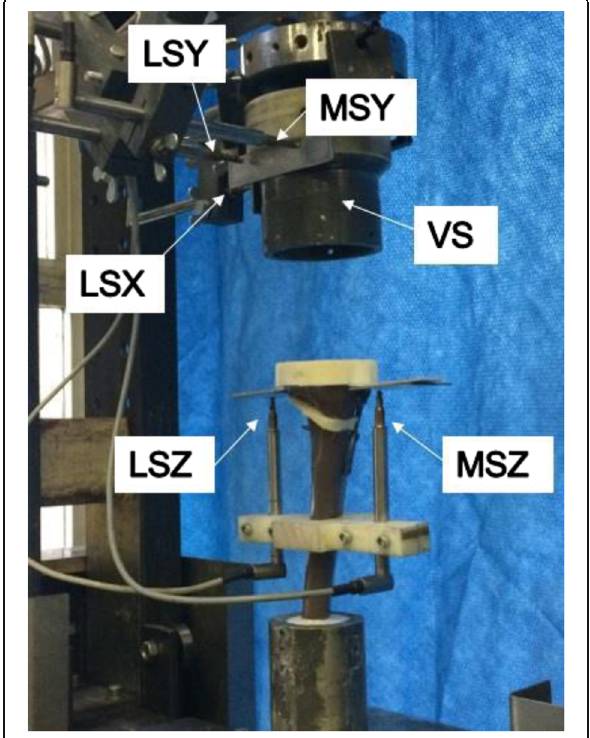
Fig. 2 Positioning of displacement sensors around the tibial head (posteromedial view). VS = Vertical Sensor; LSX = Lateral Sensor X-Axis; LSY = Lateral Sensor Y-Axis; MSY = Medial Sensor Y-Axis; LSZ = Lateral Sensor Z-Axis; MSZ = Medial Sensor